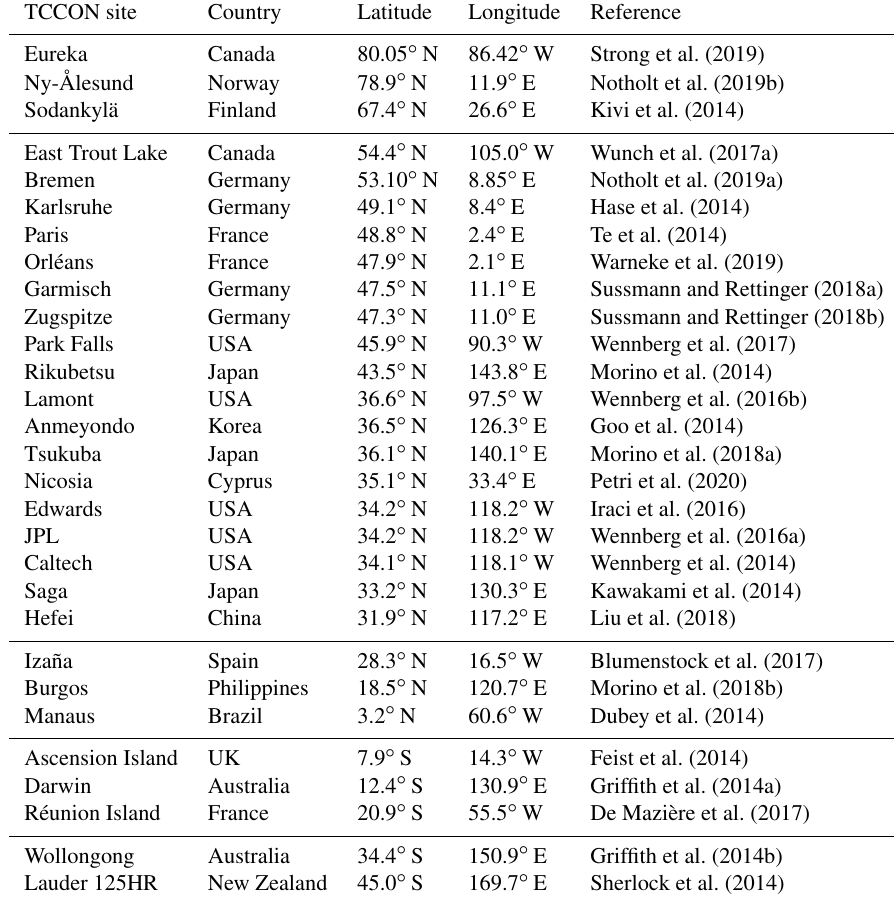
Table A1. TCCON sites used for evaluation of posterior CO 2 fields of the v10 OCO-2 MIP experiments. TCCON